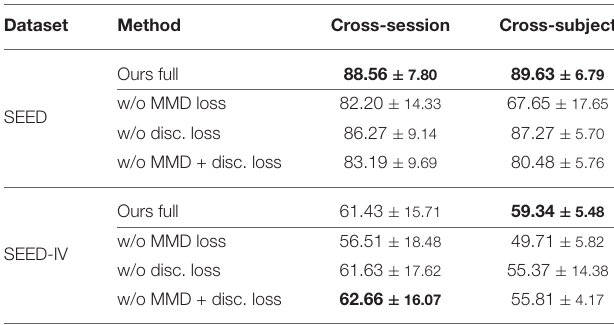
TABLE 3 | Ablation study of MS-MDA on SEED and SEED-IV of